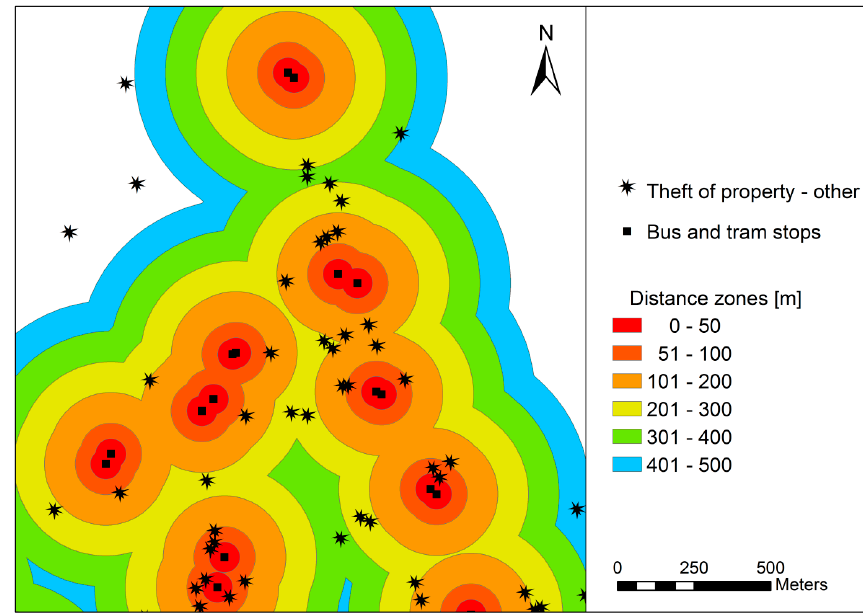
Figure 3. Spatial distribution of the crime type “theft of property—other” together with multiple buffer areas around the land use type “bus and tram stops”.